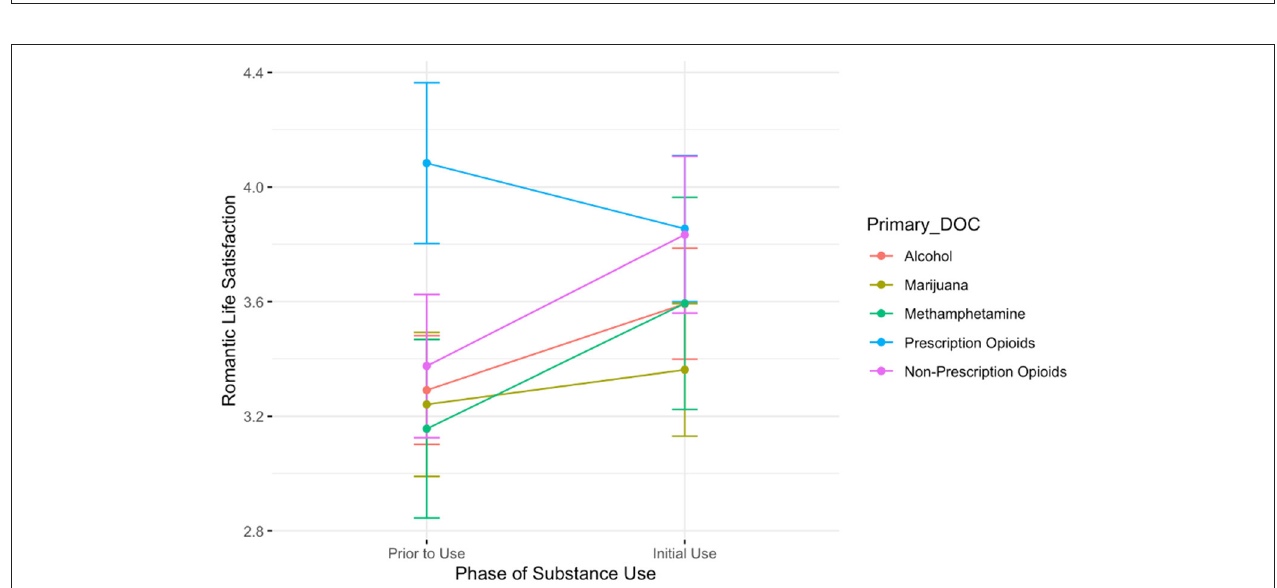
FIGURE 3 | A plot showing the average romantic life satisfaction scores for participants prior to the onset of substance use and during the initial stages of use. Lines are colored by participant primary substance of choice. The only group showing a decrease in romantic life satisfaction between these two timepoints is those who reported using prescription